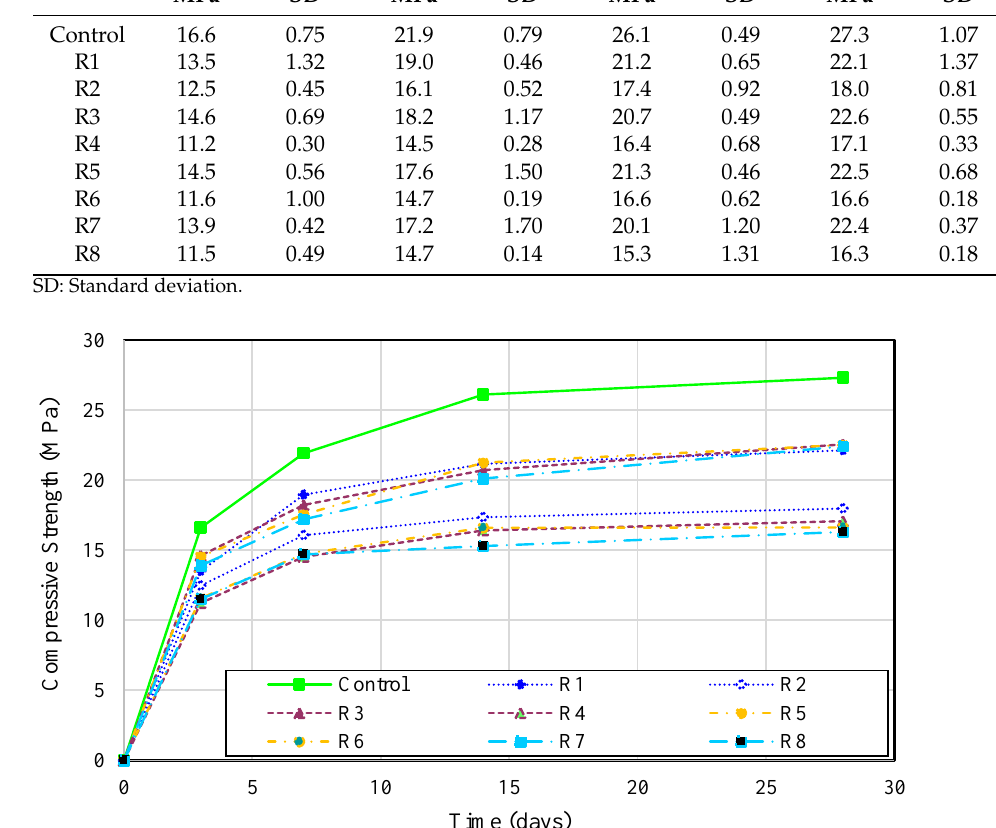
Figure 7. Compressive strength of concrete mixes.